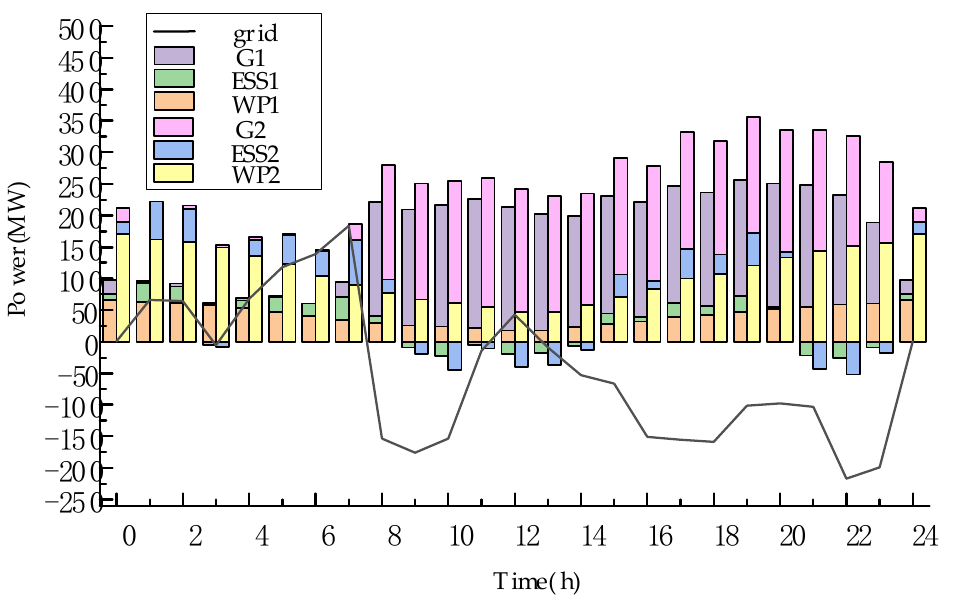
Figure 6. Power operation diagram under Scheme B.